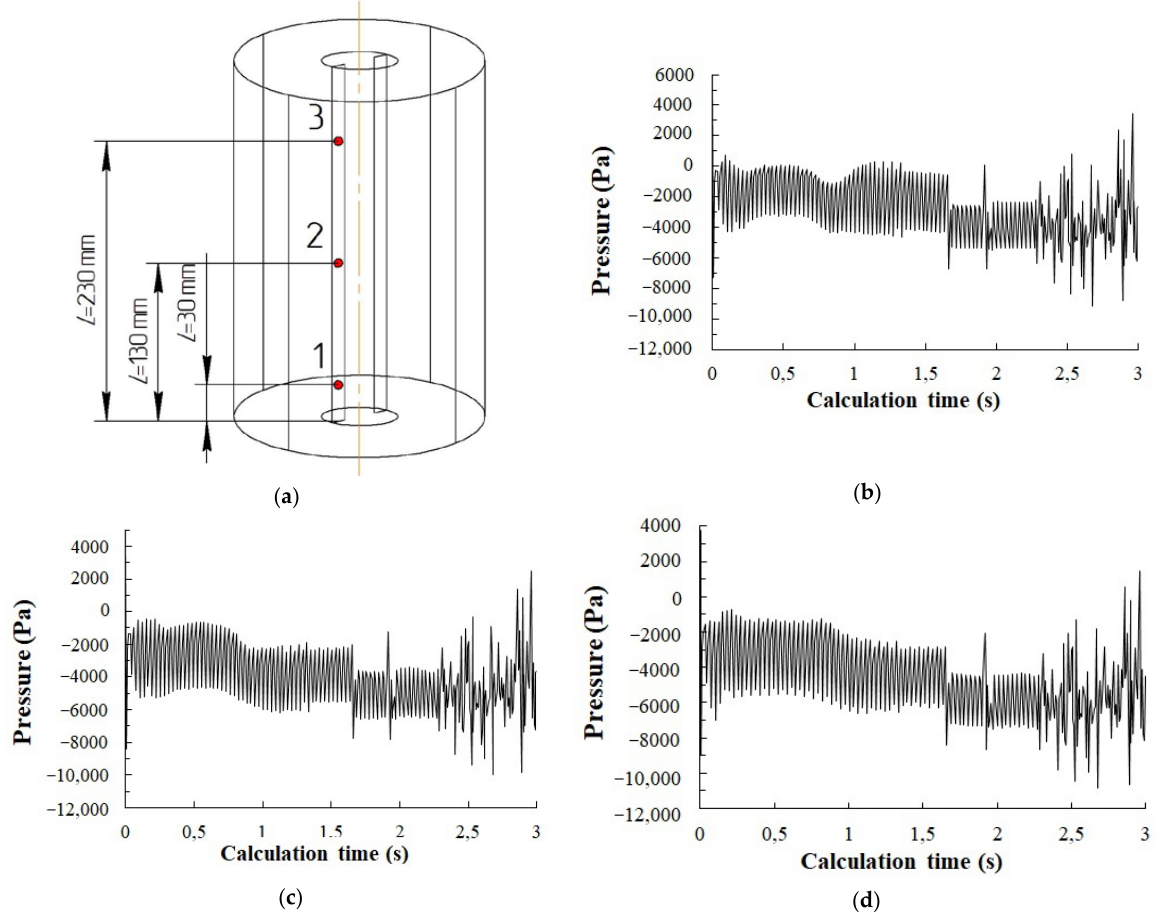
Figure 6. Changes in the maximum ( P 1 ) and minimum ( P 2 ) pressure in the fluid with time in sim- ulation ( a ) n = 1000 (rpm), h = 0.05 (m), and the stirrer rotational speed ( b ). The stirring process simulation (Figure 7b) demonstrates that the reduced pressure regions occur along the entire paddle height (point 1–3). The paddle height increase causes the local region size increase. This is the process driver that conditions the supply of gas from the vortex cavity into the entire volume of liquid, therefore ensuring the gas content growth.